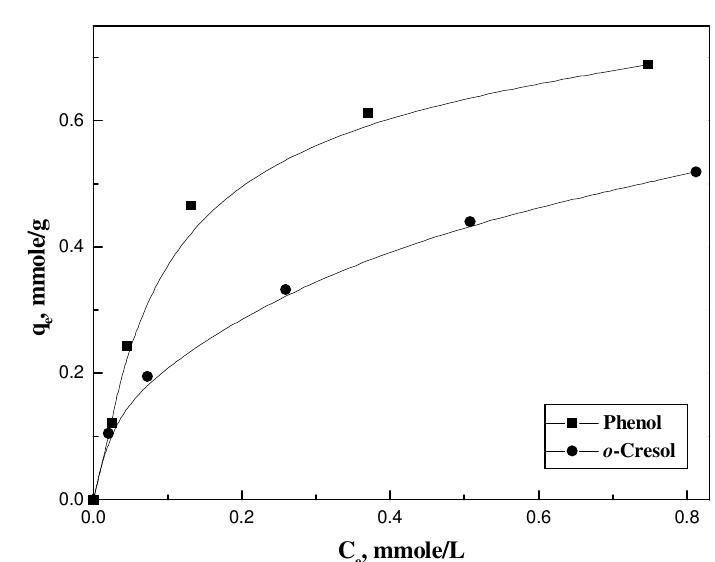
Figure 1. Isotherm plots for adsorption of phenol and o -cresol on activated carbon The equilibrium adsorption data obtained were then fitted to Freundlich, Langmuir and